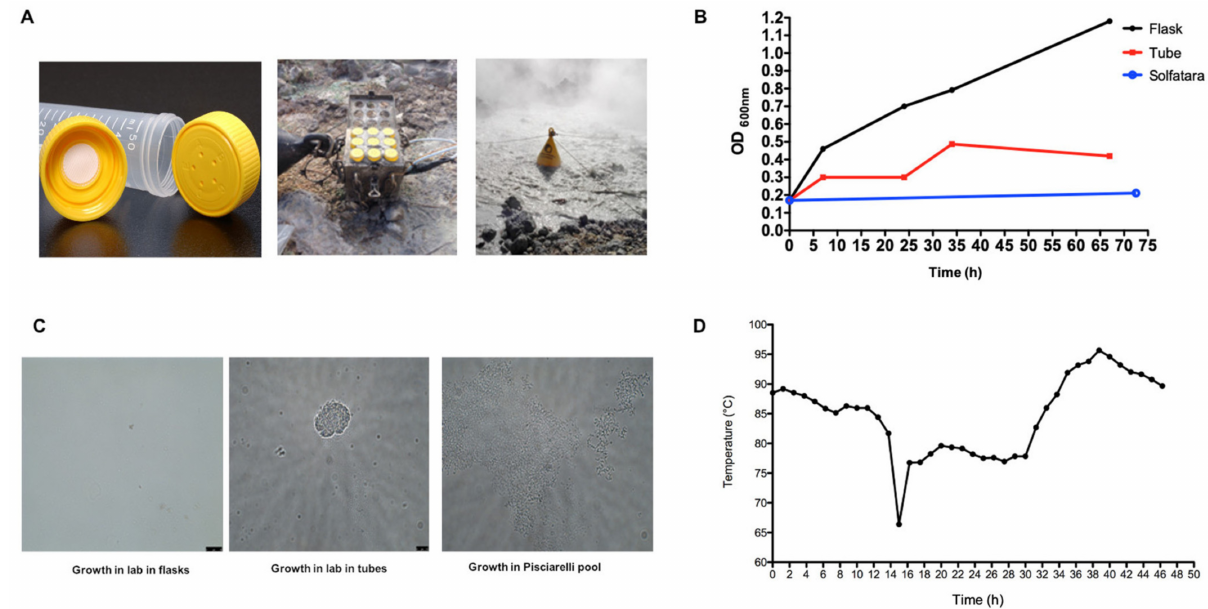
Figure 4. Growth of S. solfataricus in solfatara Pisciarelli. ( A ) Device for the S. solfataricus growth in the Pisciarelli pool; ( B ) growth curves of S. solfataricus WT in YCS medium, in lab (flasks and plastic tubes at 80 ◦ C, black and red, respectively) and in Pisciarelli pool in plastic tubes (blue); ( C ) contrast phase microscopy of cultures in lab, in flasks and plastic tubes, respectively and in Pisciarelli pool in plastic tubes; ( D ) fluctuation temperatures measured in Pisciarelli pool during S. solfataricus